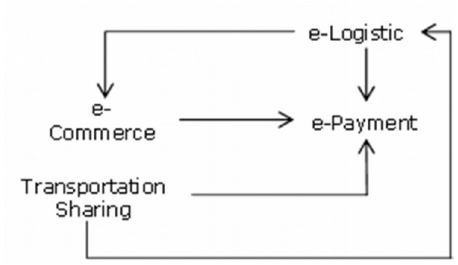
Figure 4. Sample 1 of E-Logistic Initiative